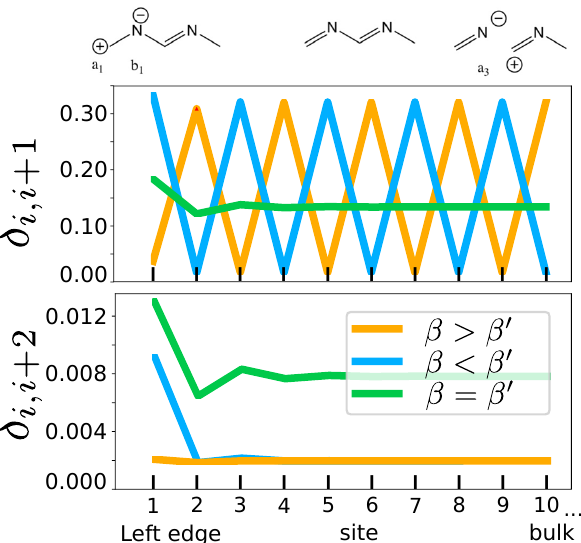
Figure 9. Resonance schemes, δ i , i + 1 and δ i , i + 2 for the di-atomic lattice with an on-site term ( ∆ V = − 2) added to the second sublattice. The chain is 20 atoms long (only 10 sites are shown) and the hoppings β , β (cid:48) are the same as in Figure